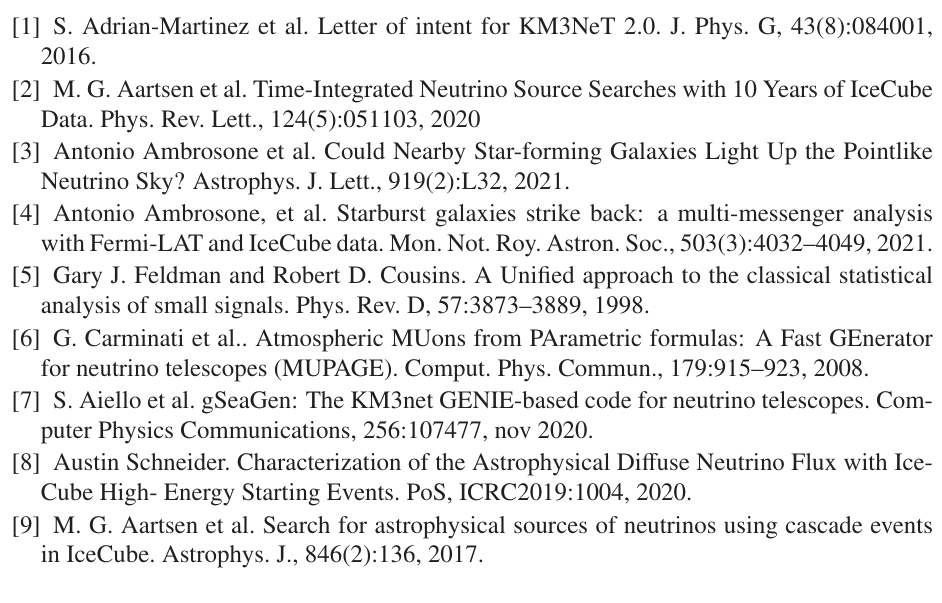
In particular, the left panels of figures 2-4 show the sensitivity compared with the spec- trum after 10 years (20) of data taking of 2 ARCA building blocks for SMC and NGC 1068 (Circinus). The right panel shows the obtained MRF scaling with time in the best-fit scenario. In each case, the results show that in few-years ARCA will be able to test these hadronic sce- nario posing strict constraints on the hadronic budget of Starburst